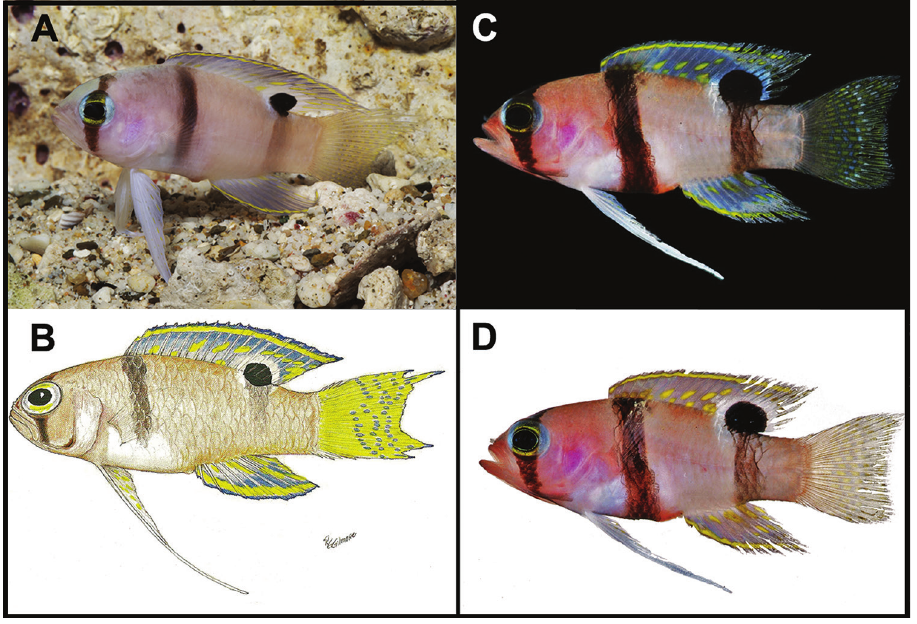
Figure 8. Lipogramma evides A Aquarium photograph by Barry Brown, Substation Curacao B USNM 276560, 45.3 mm SL, illustration by Grant Gilmore in Gilmore and Jones (1988: fig. 1) C and D USNM 414885, 24.4 mm SL, photos by D. R. Robertson and C. C. Baldwin against black ( C ) and white ( D )